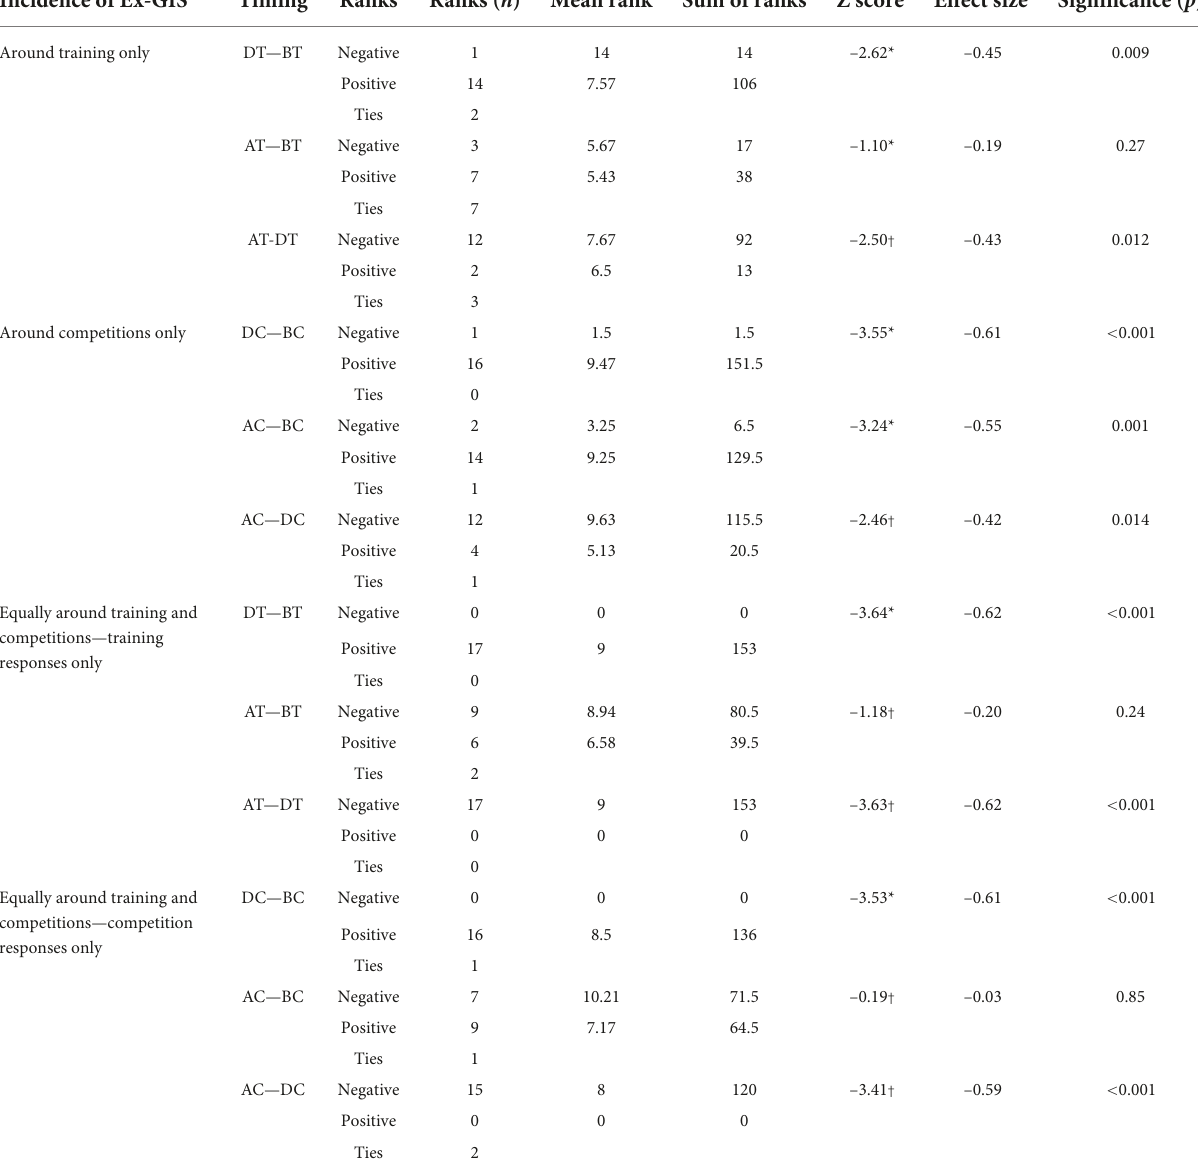
TABLE 3 Exercise-associated gastrointestinal symptoms incidence reported by endurance athletes before, during and after training or competition ( n = 137 respondents). Incidence of